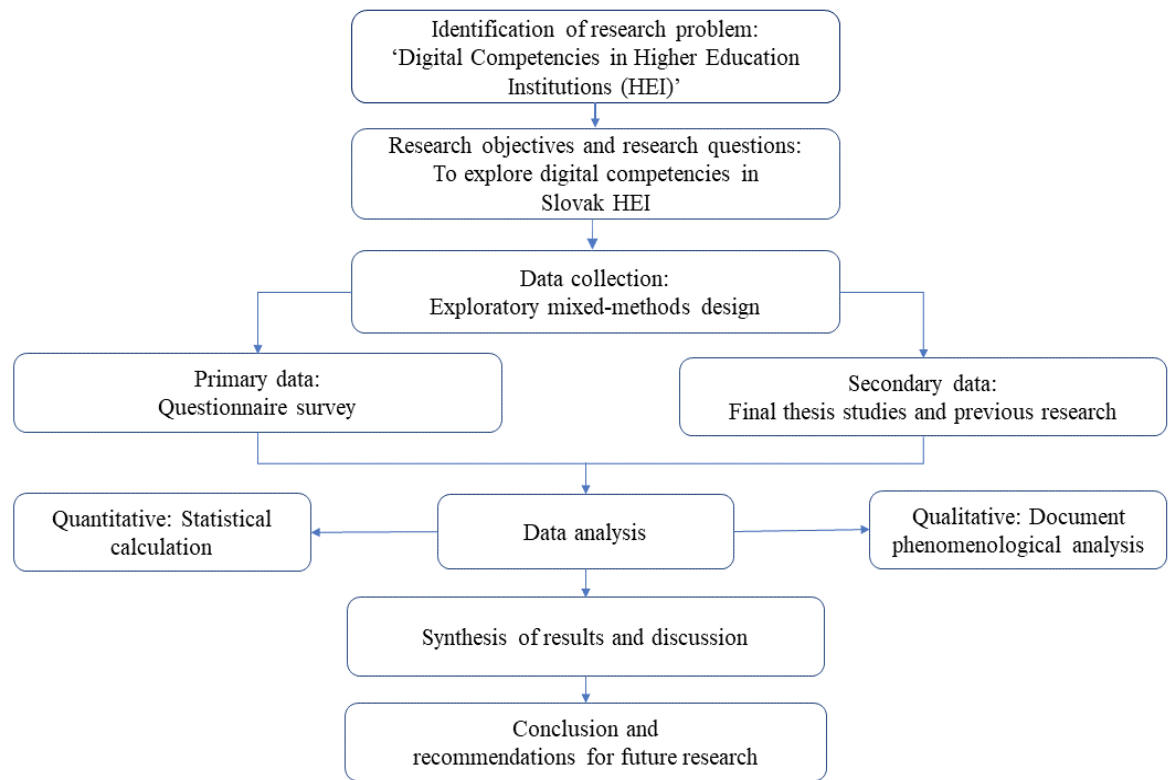
Figure 1. Flow chart of the research process